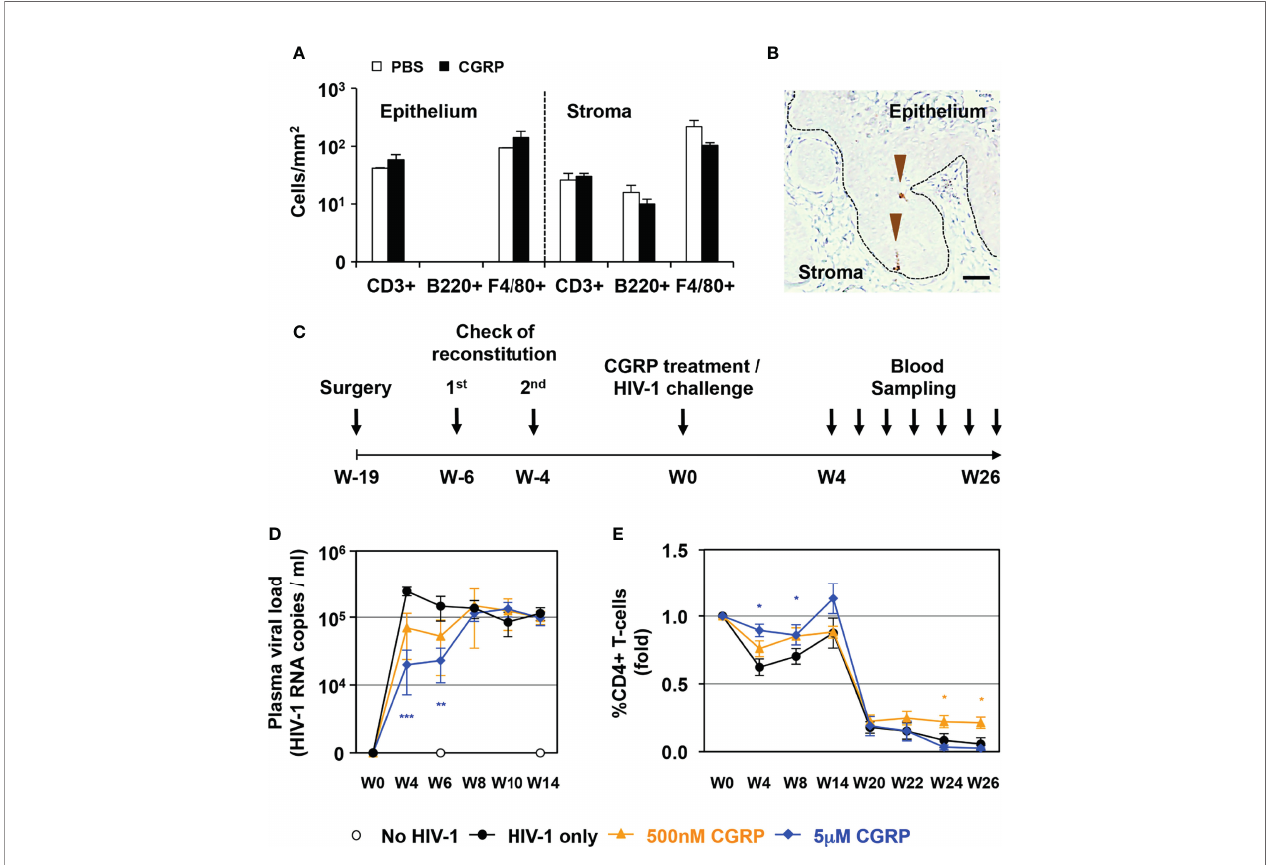
FIGURE 1 | CGRP limits mucosal HIV-1 transmission in-vivo . (A) CGRP (1 m M) or PBS were topically applied intravaginally in normal female BALB/c mice (n = 3 animals per group). Vaginal tissue sections were examined by immunohistochemistry for the presence of CD3+ T-cells, B220+ B cells and F4/80+ macrophages. Shown are mean ± SEM cell densities expressed as cells/mm 2 (of n = 3 independent experiments) in either the vaginal epithelium or stroma. (B) Representative image of the vaginal tissue of humanized BLT mice, showing expression of human langerin (arrowheads) in the epithelium; broken line denotes the basement membrane and scale bar = 20 m m. (C) Experimental schedule for preparing humanized female BLT mice, intravaginally applying CGRP or PBS followed by vaginal challenge with high-dose HIV-1 JRCSF, and subsequent blood sampling for measurement of plasma viral loads and CD4+ T-cells counts. (D, E) Shown are mean ± SEM (n = 5 BLT mice per group) of plasma viral loads (HIV-1 RNA copies/ml) or CD4+ T-cells percentages (fold). *p < 0.0500, **p < 0.0050, ***p < 0.0005; two- sided Student ’ s